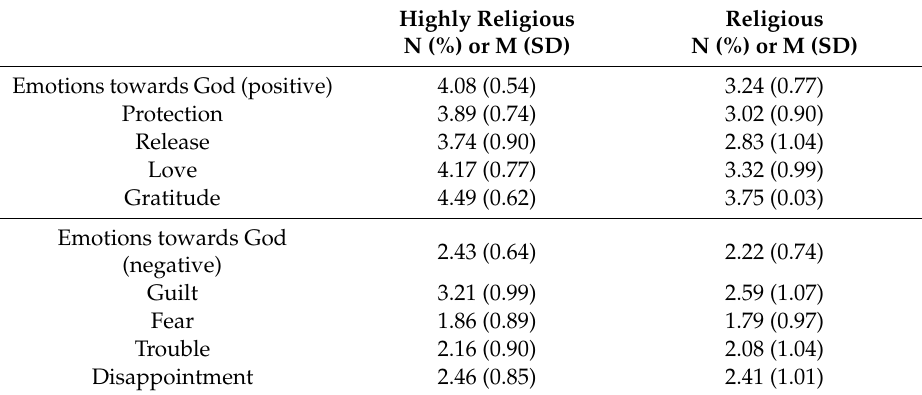
Table 4. Emotions towards God Scale of the